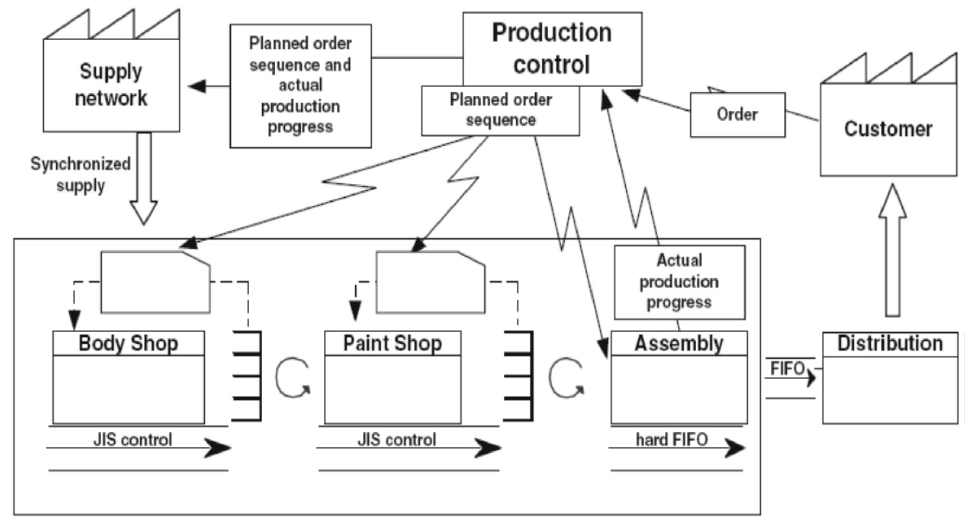
Figure 1. Vehicle flow through workstations (Meissner,